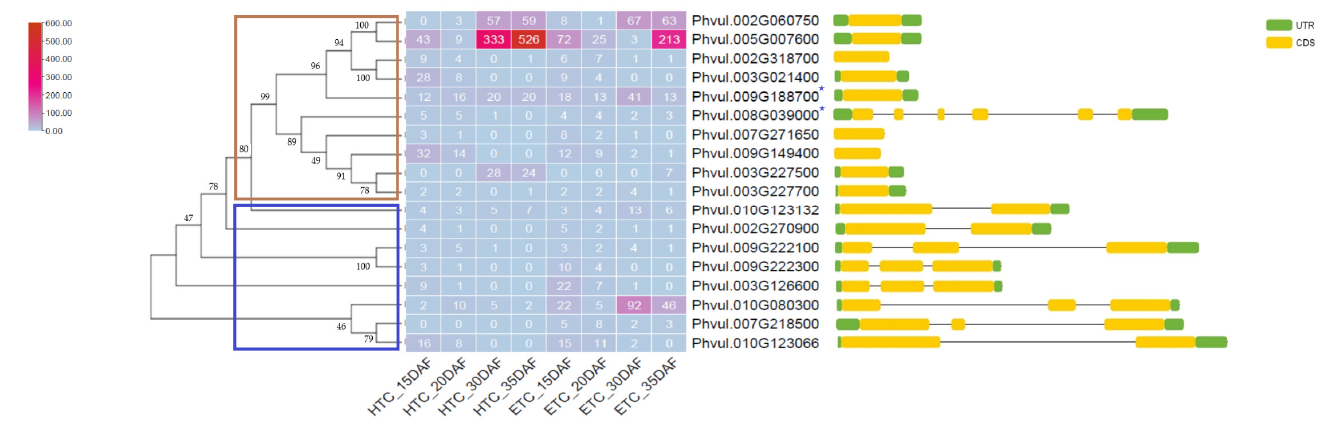
Figure 3. A hierarchical clustered heat map showing the RPKM expression and the gene structure of highly expressed genes encoding the pectin methyl-esterases (PMEs) and pectin methyl-esterase inhibitors (PMEIs) from fast-cooking (Rosecoco, ETC) and slow-cooking (Pinto, HTC) P. vulgaris varieties . Brown and indigo boxes indicate the PMEI and PME clusters, respectively. PME-encoding genes that clustered together with PMEIs are denoted by indigo asterisks. UTR: untranslated region; CDS: coding sequence.